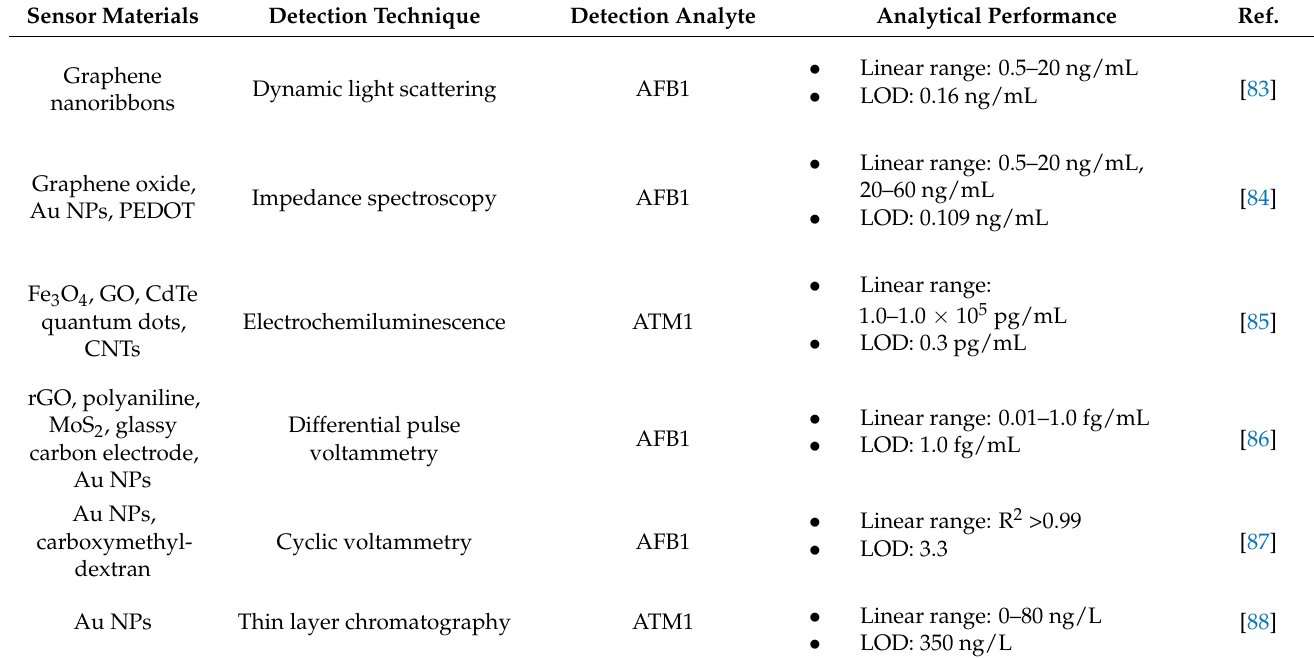
Table 2. Comparison between the performances of the sensing prototypes based on different detection